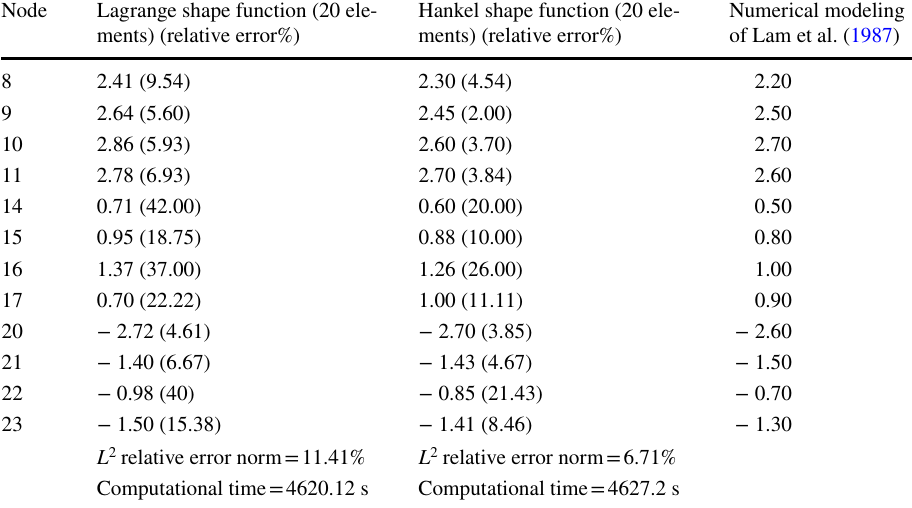
Table 8 Comparison of the results obtained from Hankel shape function, Lagrange shape function and numerical solution of Lam et al. (1987) t = 1316min at for the fifth problem